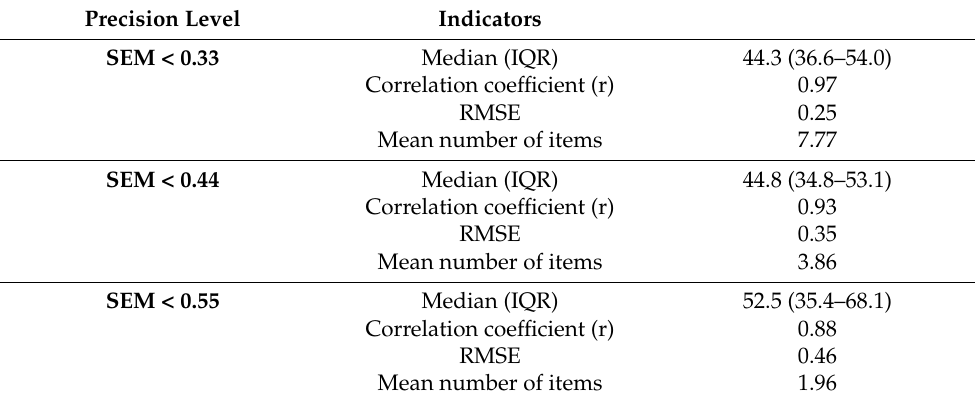
Table 4. Mean scores and precision indicators for CAT